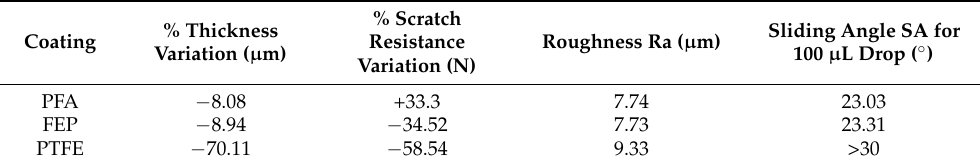
Table 5. Properties of fluoropolymeric coatings after 4 s of wear by plastic-polymeric particles projected at 0.4 MPa.